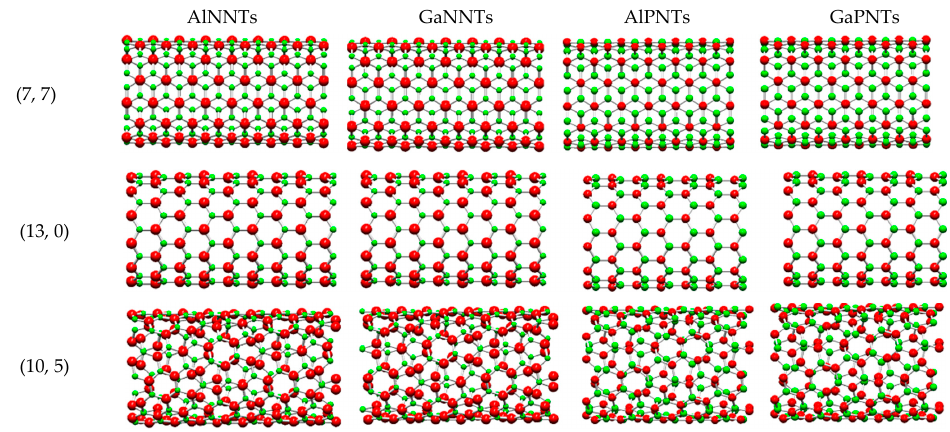
Figure 2. Illustration of the three main symmetry groups for AlN, GaN, AlP and GaP nanotubes with comparable diameters, constructed using the Nanotube Modeler © software. Al and Ga atoms are represented in red and N and P atoms are in green.